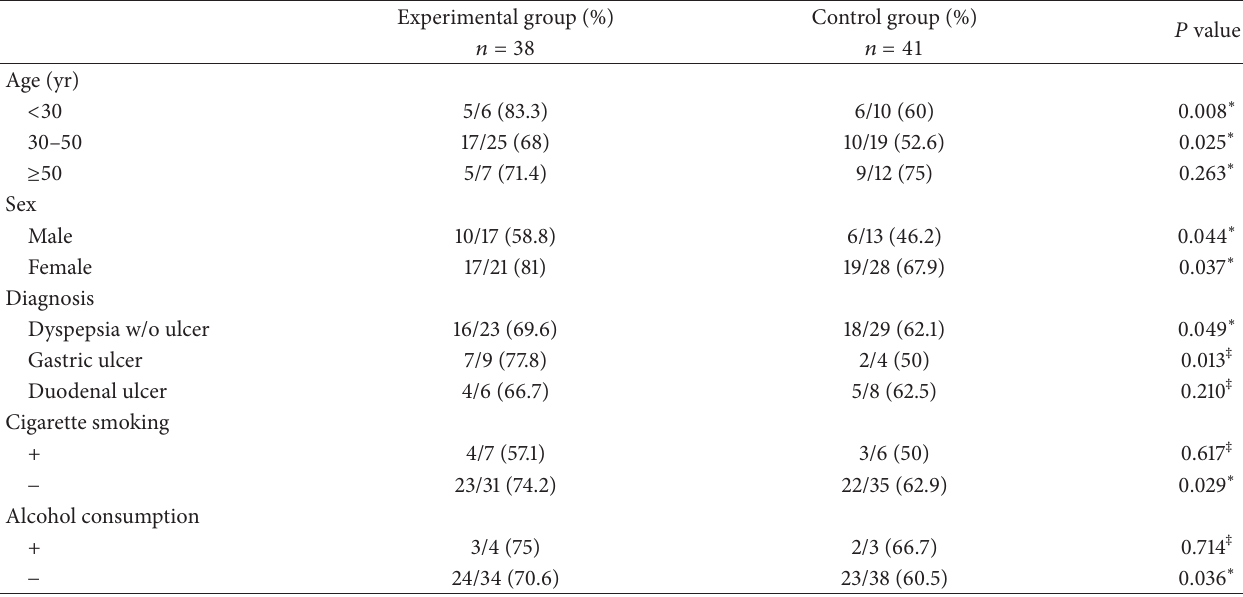
Table 2: Comparison the rate of H. pylori eradication according to demographics and clinical characteristics.